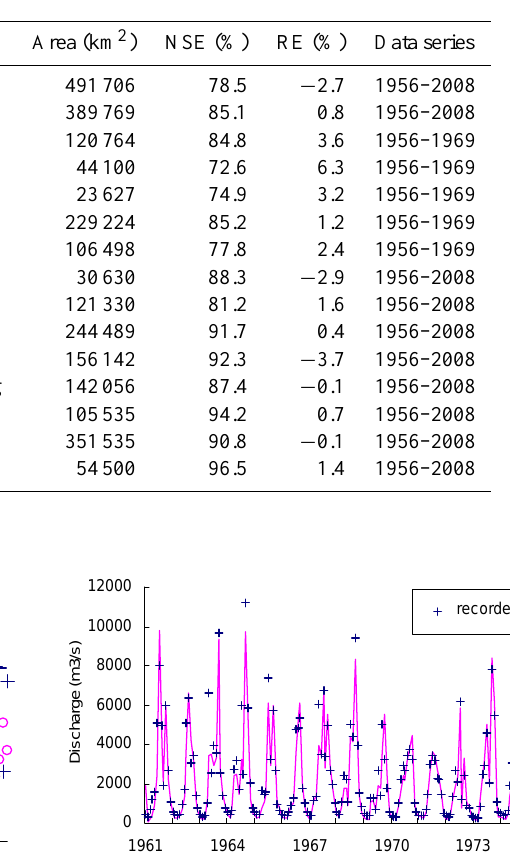
Table 3. Results of simulation of monthly discharges at 15 key hydrometric stations on major rivers in China.